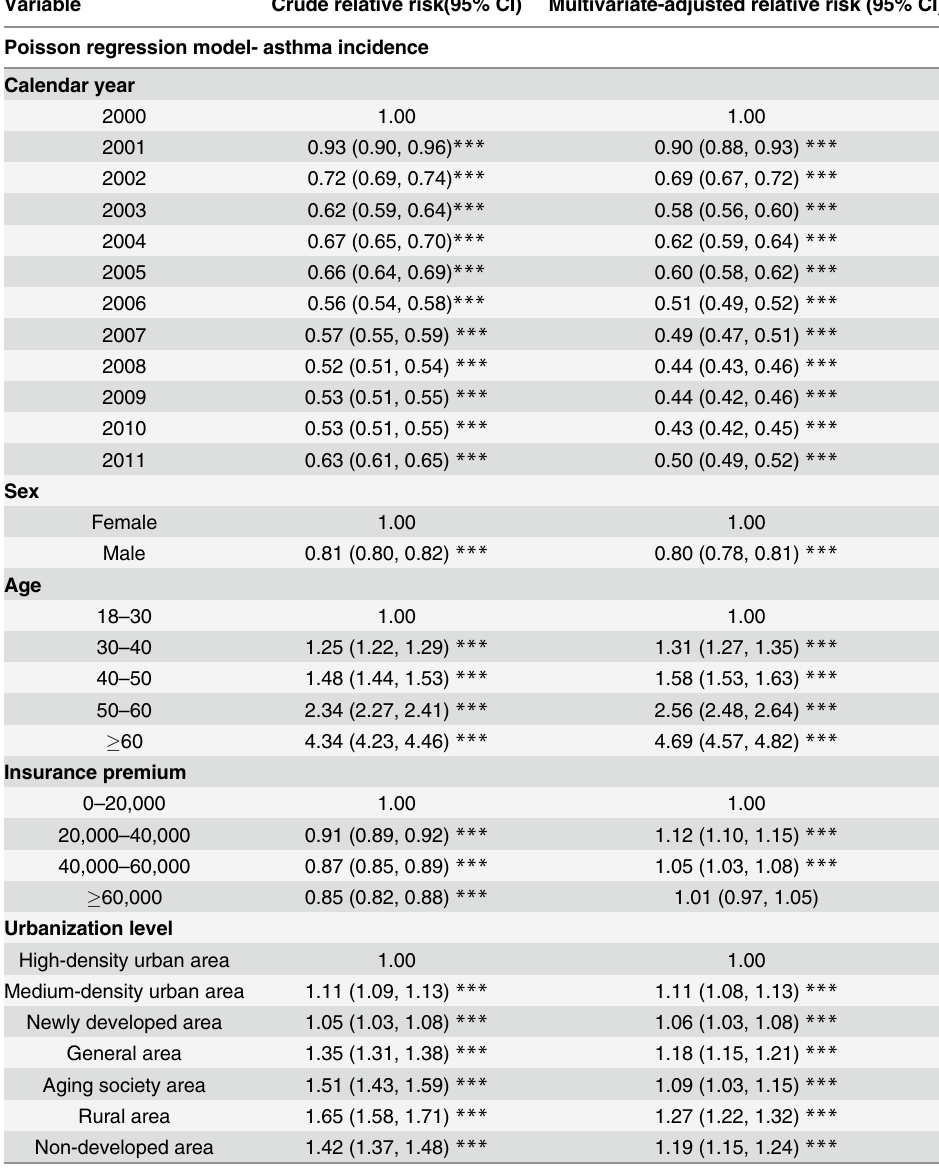
Table 3. Multivariate-adjusted relative risk of annual incidence rates of t asthma for sex, age, time, insurance premium, and urbanization level.